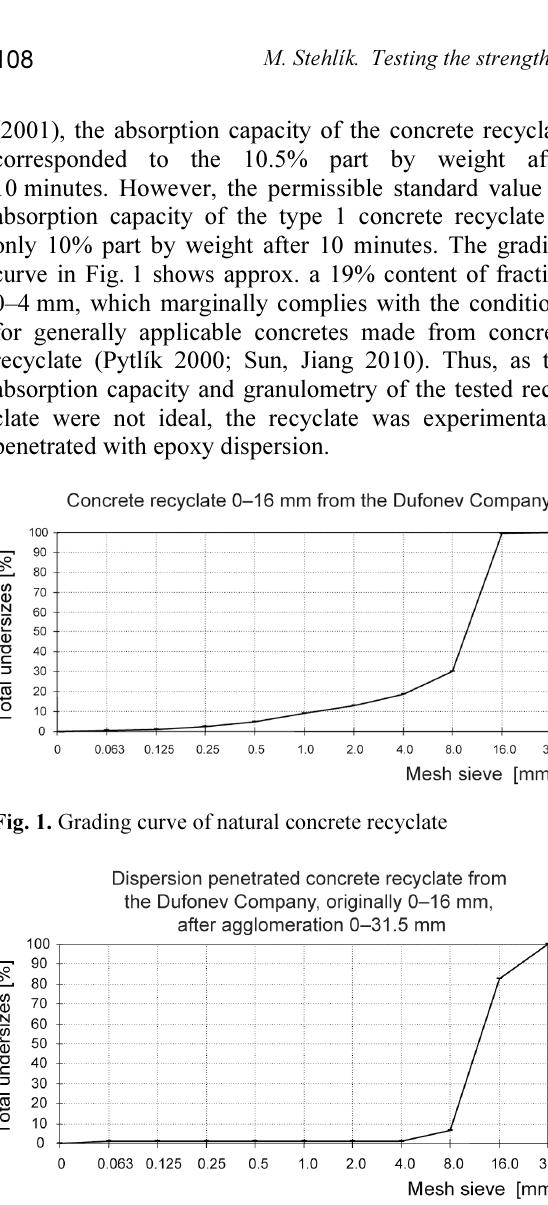
Fig. 2. Grading curve of dispersion-penetrated concrete recyclate